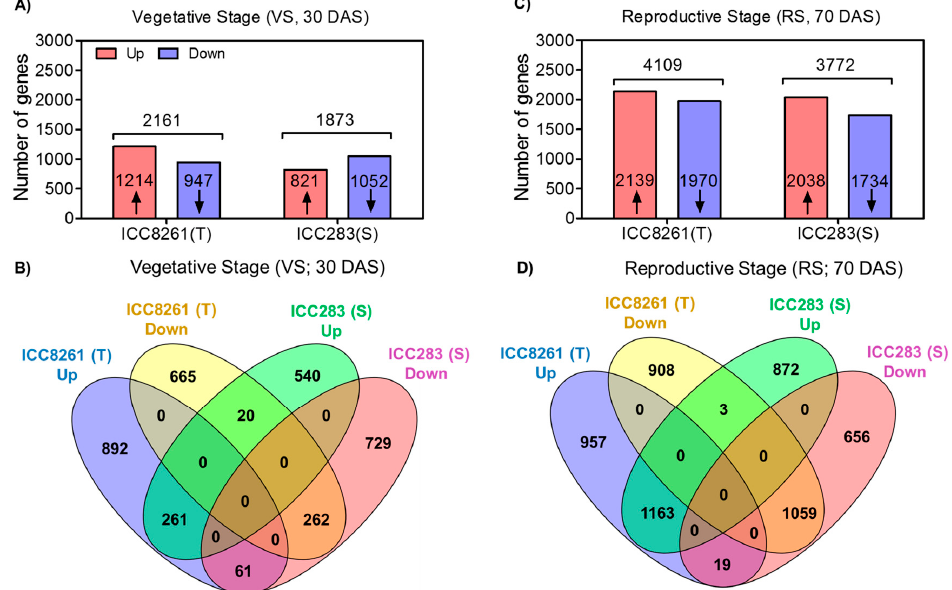
Figure 2. Bar graphs and Venn diagram representing genotype- and developmental stage-specific differentially expressed genes (DEGs) in response to drought stress. ( A ) DEGs up- and down-regulated in the tolerant (T, ICC8261) and sensitive (S, ICC283) genotypes at the vegetative stage (VS); ( B ) Venn diagram showing commonly up- and down-regulated DEGs amongst the genotypes at the vegetative stage (VS); ( C ) DEGs up- and down-regulated in the tolerant (T, ICC8261) and sensitive (S, ICC283) genotypes at the reproductive stage (RS); ( D ) Venn diagram showing commonly up- and down-regulated DEGs amongst the genotypes at the reproductive stage (RS).